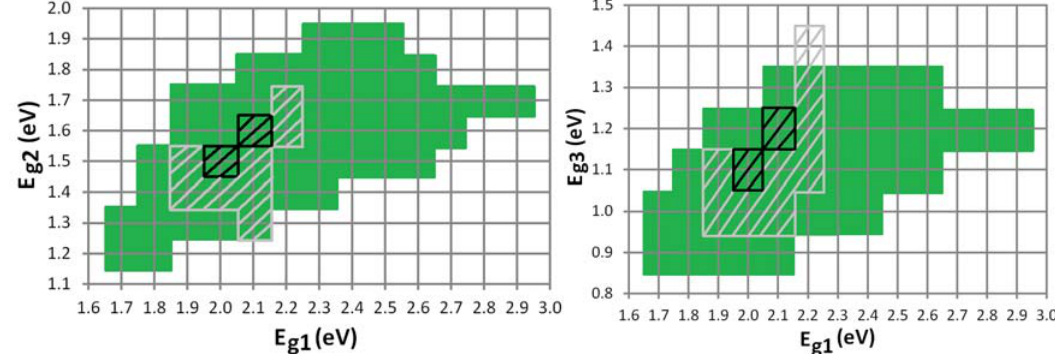
Figure 9. The green region and the black hatched region define the range of sufficient bandgap combinations (>90% of the maximum) of respectively a stacked and a monolithic organic triple-junction cell with absorption windows of 300 nm for the subcells. The grey hatched region defines the “still acceptable” range (>80% of the maximum) for a monolithic